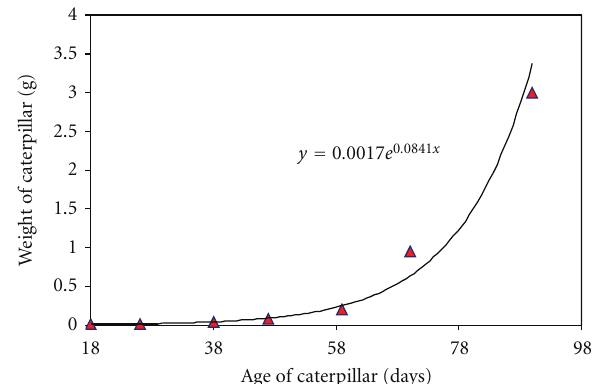
Figure 3: Developmental velocity of Anaphe panda silkworm in the Kakamega